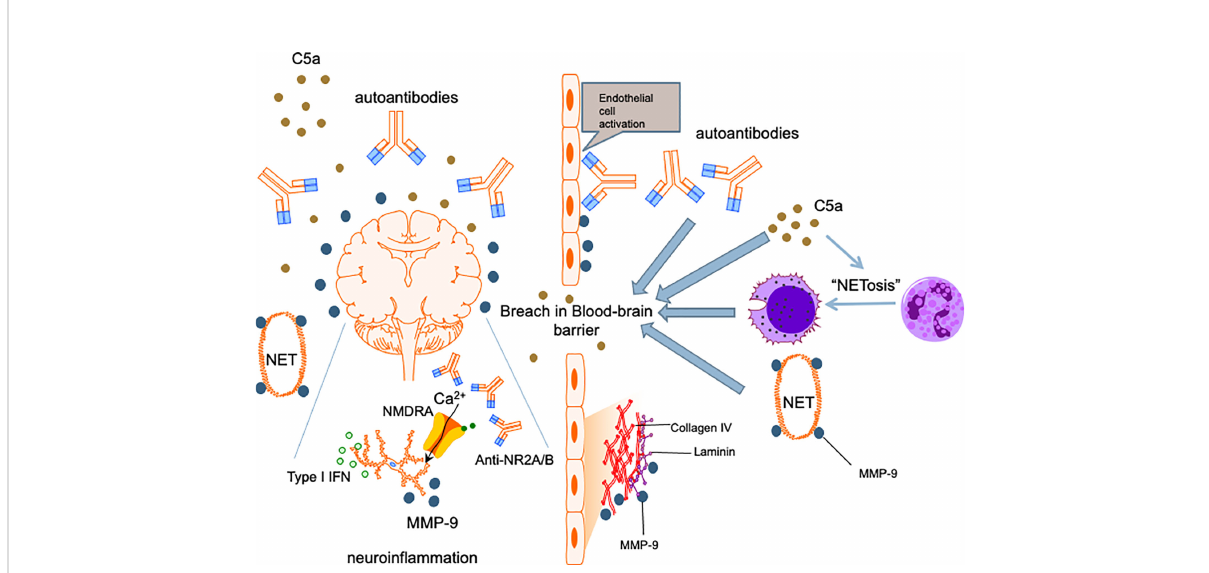
FIGURE 2 Proposed mechanism for NPSLE. Insults to the BBB allow penetration of the central nervous system by neutrophils and other in fl ammatory mediators. Cognitive de fi cits and other neuropsychiatric manifestations are caused by cytokines such as type I IFNs, anti-neuronal autoantibodies including anti-NR2A/B and matrix metalloproteinase-9 instigating neuronal damage and induction of apoptosis. C5a complement fragments are chemotactic and promote migration of immune cells including neutrophils into the CNS, an effect ampli fi ed by the ability of C5a to enhance NETosis and increase permeability of the BBB. C5a also exerts direct neurotoxic effects, contributing to further neuropsychiatric insults in